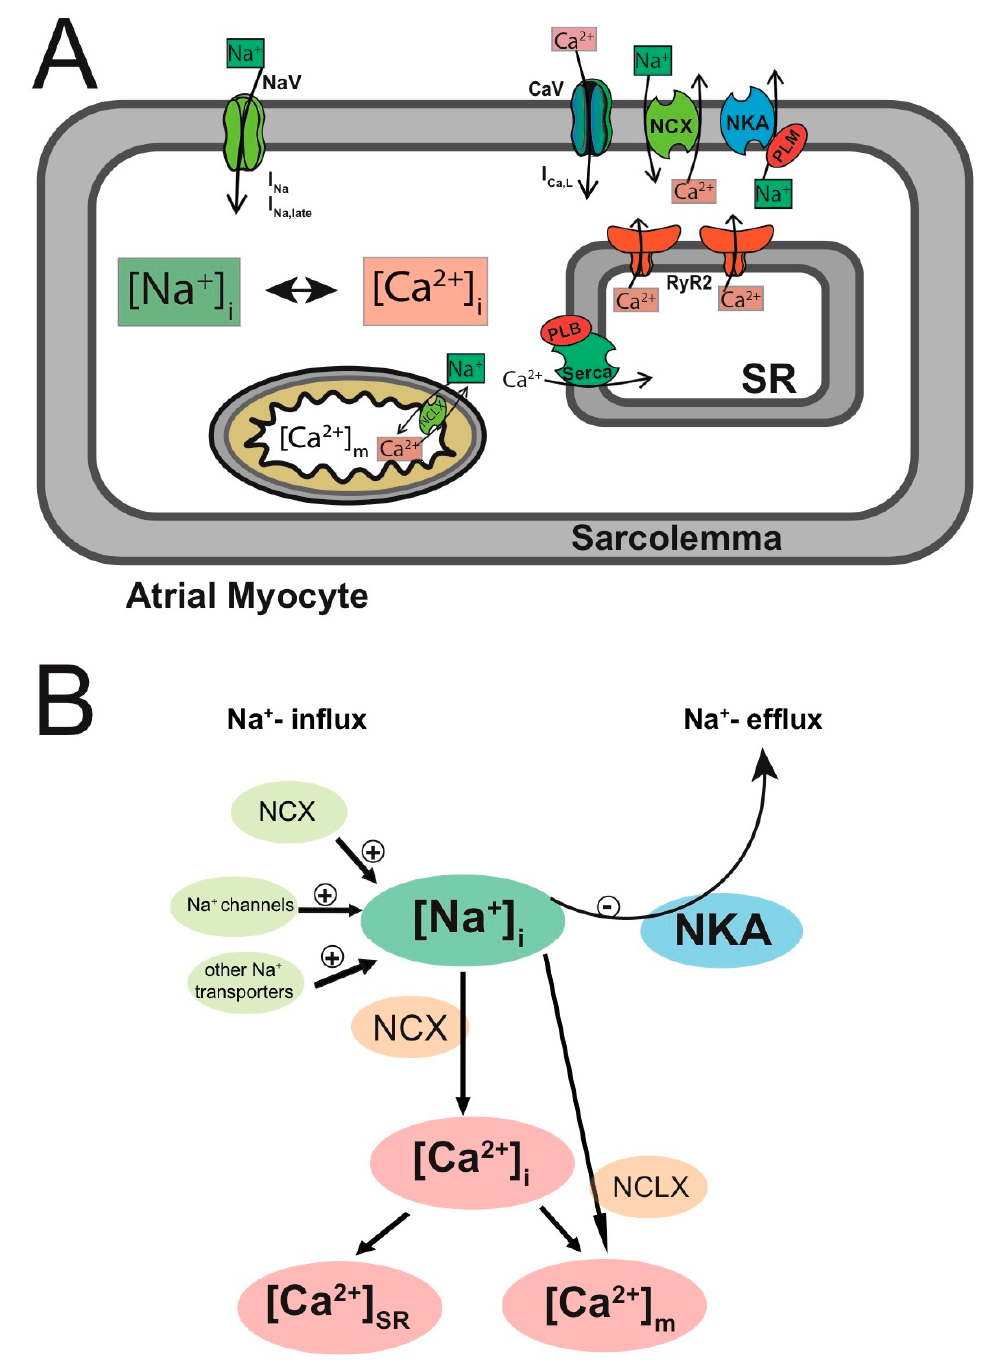
Figure 2. Intracellular Na + and Ca 2+ signaling in atrial myocytes. ( A ) Schematic depicting intracellular Na + and Ca 2+ signaling in atrial myocytes. ( B ) Schematic depicting the interdependence of intracellular Ca 2+ and Na + homeostases. See text for details. [Na + ] i : intracellular Na + concentration; [Ca 2+ ] i : intracellular Ca 2+ concentration; NaV: voltage-dependent Na + channels; I Na : Na + current; I Na,late : ‘late’ Na + current; CaV: L-type Ca 2+ channel (CaV1.2); I Ca, L : L-type Ca 2+ current; NCX: Na + /Ca 2+ exchanger; I NCX : Na + /Ca 2+ exchange current; NCLX: mitochondrial Na + /Ca 2+ exchanger; NKA: Na + /K + ATPase; I NKA : Na + /K + ATPase current; PLM: phospholemman; RyR2: ryanodine receptor type 2; Serca: sarcoplasmic reticulum Ca 2+ ATPase; PLB: phospholamban; SR: sarcoplasmic reticulum; [Ca 2+ ] SR : SR Ca 2+ concentration; [Ca 2+ ] m : mitochondrial Ca 2+ concentration.